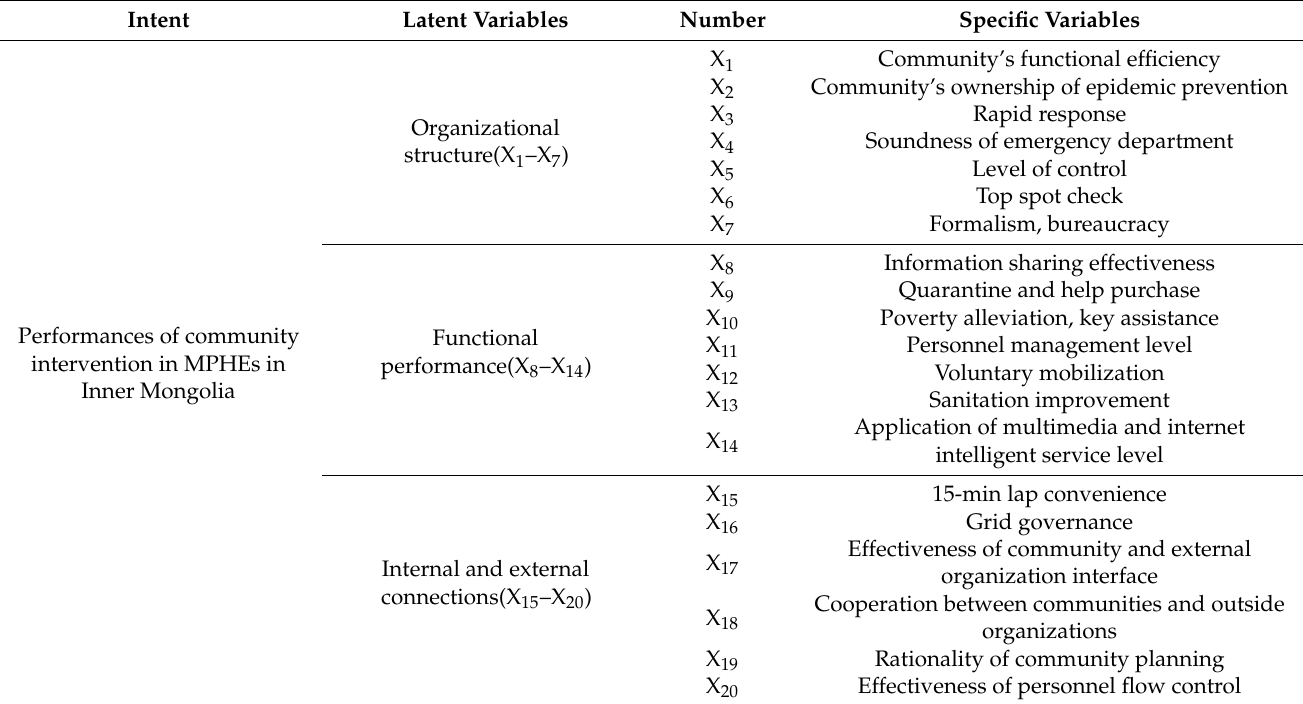
Table 1. Community intervention questionnaire for Inner Mongolia.